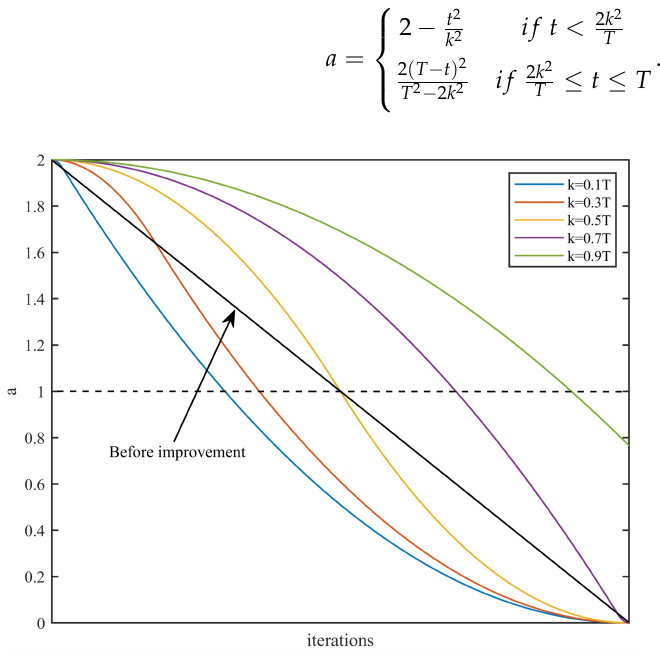
Figure 4. The trend of a changing with the number of iterations when k takes different